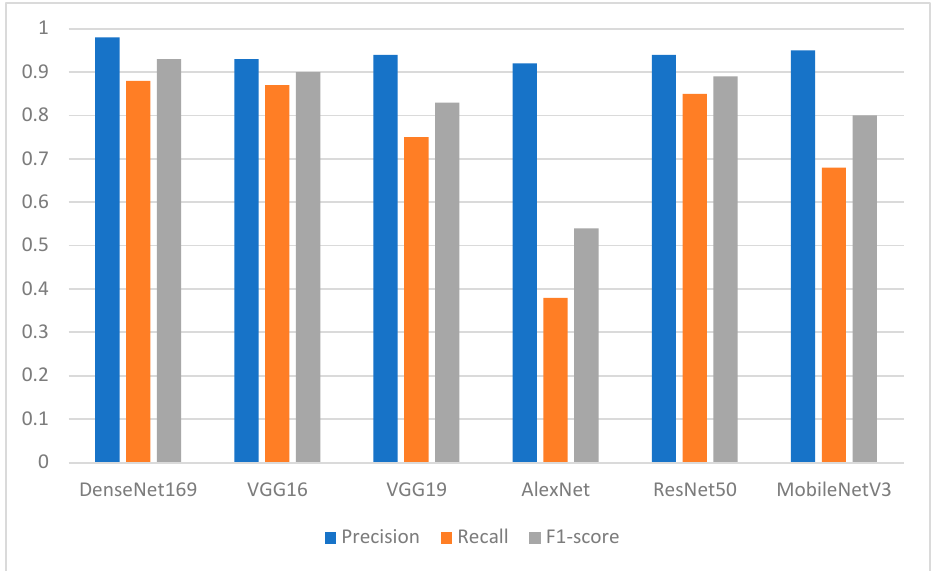
Figure 10. Performance of the models in terms of precision, recall, and F1-score with respect to class 0 (class of normal teeth).